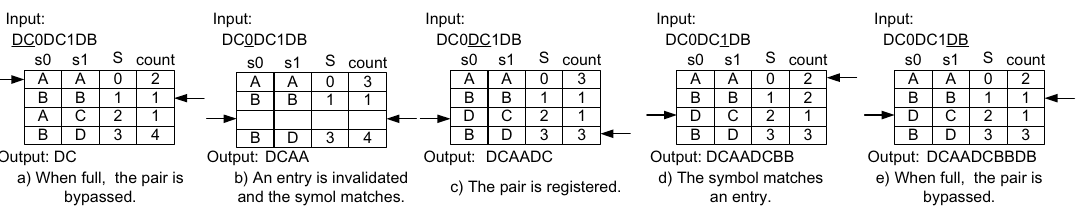
Figure 9. Example of a decompression mechanism using the lazy compression